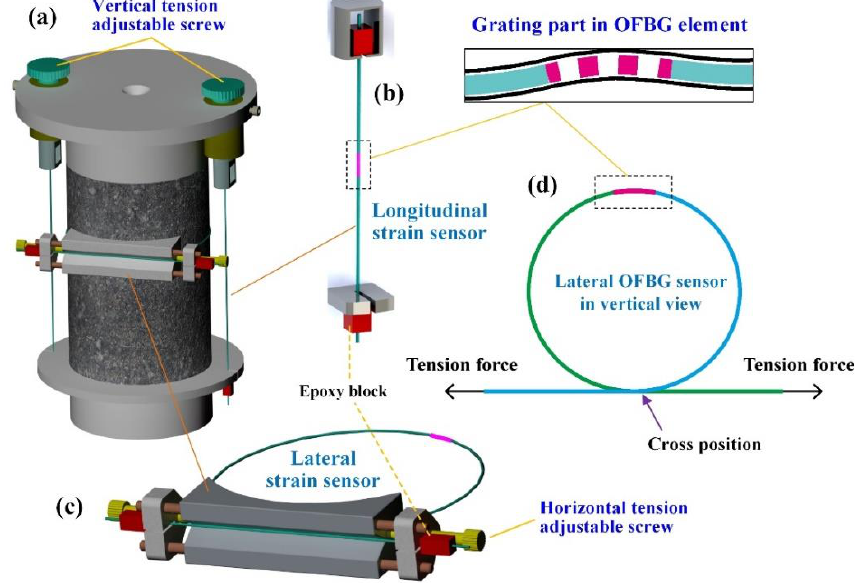
Figure 2. Schematic setup of ( a ) the cylindrical HMA sample in DM tests with two ( b ) vertical OFBG sensors and one ( c ) horizontal OFBG sensor, in which the ( d ) OFBG element was fixed with two epoxy resin blocks and stretched with two screwing nuts.